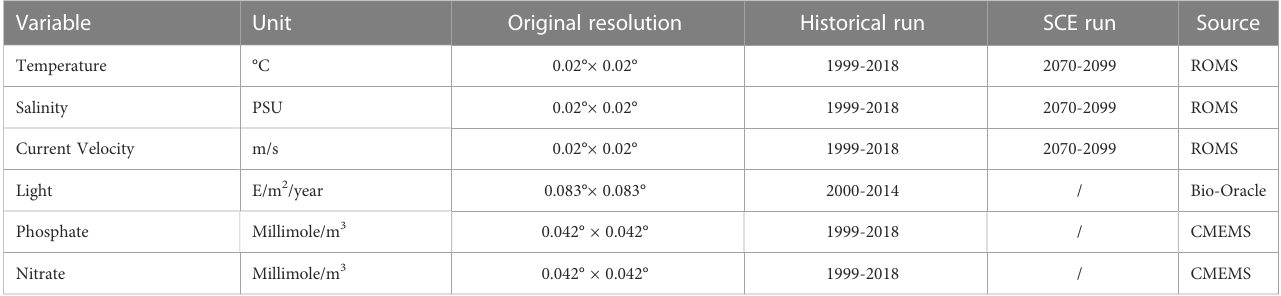
TABLE 2 Summary details of environmental